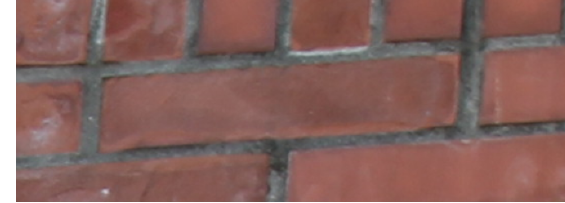
Figure 11. Example of misclassified